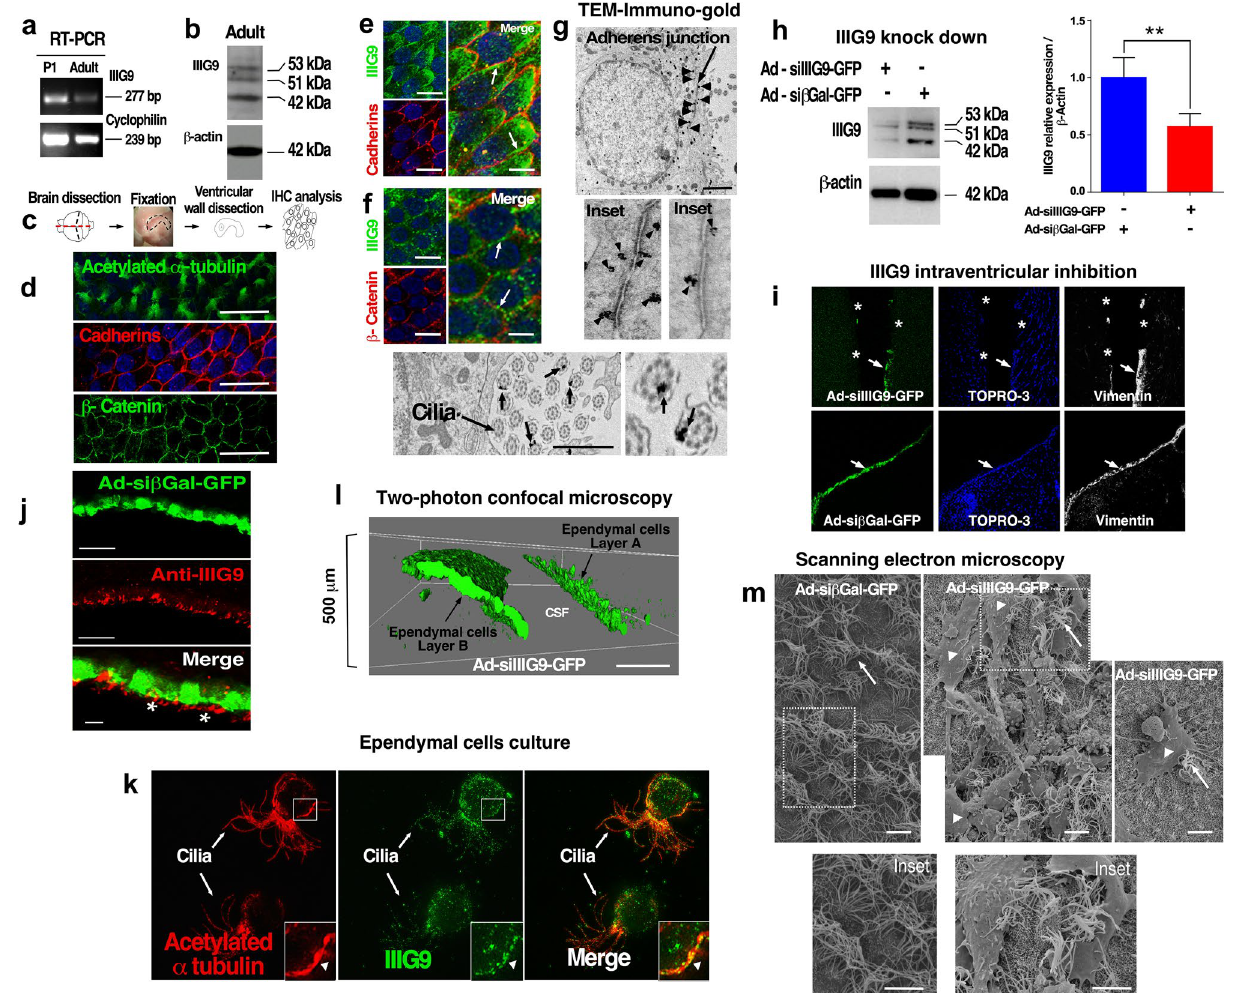
Figure 1. IIIG9 localization in adherens junctions in adult ependymal cells. ( a ) IIIG9 expression analysis using RT-PCR. Samples isolated from postnatal day one (P1) and the adult ventricular wall. ( b ) Western blot analysis. Sample isolated from the adult ventricular wall. Three main bands (42 kDa, 51 kDa and 53 kDa) were detected. ( c – f ) En face wholemount preparation of the adult lateral ventricular wall and immunohistochemical characterization using anti-acetylated α-tubulin, anti-cadherins and anti-β-catenin antibodies ( d ). IIIG9/ cadherin colocalization analysis ( e , arrows in merged image). IIIG9/β-catenin colocalization analysis ( f , arrows in merged image). ( g ) Upper panel . Immunogold ultrastructural analysis for IIIG9 distribution in ependymal cell adherens junctions (arrowheads and insets). Lower panel . Immunogold ultrastructural analysis for IIIG9 distribution in cilia. A positive control immunoreaction. ( h ) Western blot analysis for in vivo IIIG9 knockdown. A representative Western blot is shown for total protein extracts isolated from adult rat ependymal walls after 6 days of i.c.v. injections with Ad-siIIIG9-GFP or Ad-sibGal-GFP. Quantitative analysis of IIIG9 expression by densitometry. ( i ) Upper panel. I.C.V. Ad-siIIIG9-GFP injections (6 days) and vimentin immunodetection. Discontinuous GFP expression (arrows) and negative areas for vimentin (asterisks) were observed in ependymal cells. Lower panel. I.C.V. Ad-siβGal-GFP injections and vimentin immunodetection. Continuous GFP expression (arrows) and a positive reaction for vimentin (arrow) were observed in ependymal cells. Hoechst was used for nuclear staining. ( j ) Ad-siβGal-GFP expression and immunohistochemistry analysis for IIIG9 in the ventricular wall. IIIG9 was located on the cilia (asterisks in merged image) and lateral membranes of the cells. ( k ) Immunohistochemical analysis using anti-IIIG9 and anti-acetylated α-tubulin antibodies in isolated ependymal cells in culture. IIIG9 localization was detected in the cilia and cellular membrane (insets). ( l ) Using 2-photon microscopy, irregular GFP expression in ependymal cells of animals treated with Ad-siIIIG9-GFP was detected (6 days). ( m ) Scanning electron microscopy of the lateral ventricular wall showing ependymal multiciliate cells (arrows and insets) in control animals and a scarce presence of these cells arranged between elongated cells (arrowheads) in Ad-siIIIG9-GFP-injected animals (6 days). All images are representative of different biologically independent samples. CSF, cerebrospinal fluid. ( a , b ) n = 3. ( d – f ) n = 6. ( g ) n = 2. ( h ) n = 3. ( i ) n = 4. ( j ) n = 3. ( k ) n = 1. ( l ) n = 2. ( m ) = 2. Scale bars = ( d ) 20 μm; ( e – f ) 10 μm (lower magnification) and 5 μm (higher magnification); ( g ) 2 μm; ( j ) 40 μm and 10 μm (merge image); ( l ) 50 μm; ( m ) 5 μm. Data is shown t-student (two-tailed) as mean ± SEM. ** P <